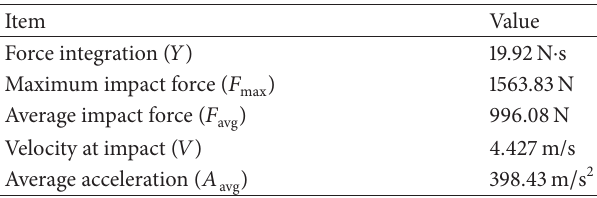
Table 2: The calculated values of the waveform of the impact